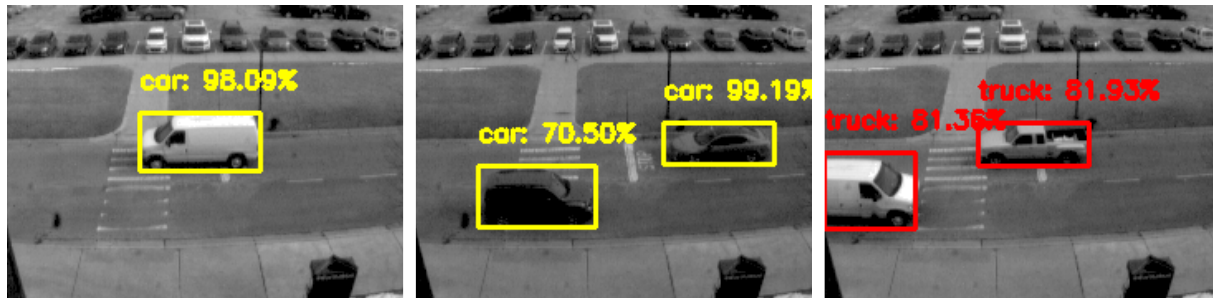
Figure 2. Object detection on some sample images ( left , center , and right ) of our collected data for one of the scenes. The object detector used in this figure is YOLOv3. In this scene, static objects, such as the parked vehicles in the top half of the scene, are disregarded.